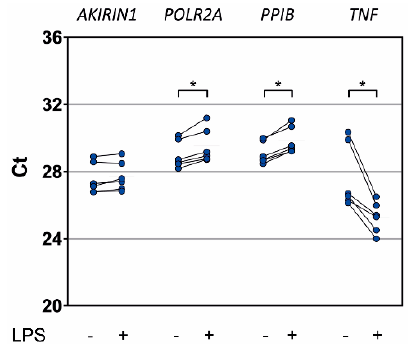
Figure 7. Reference and control gene expression in in vitro stimulated healthy donor granulocytes by RT-PCR. Granulocytes were isolated from whole blood of six healthy donors and cultured for 2 h with or without LPS (100 ng / mL). Data are represented as Ct values, and data points from same samples are connected by a line. * p < 0.05 from the Wilcoxon signed-rank test.